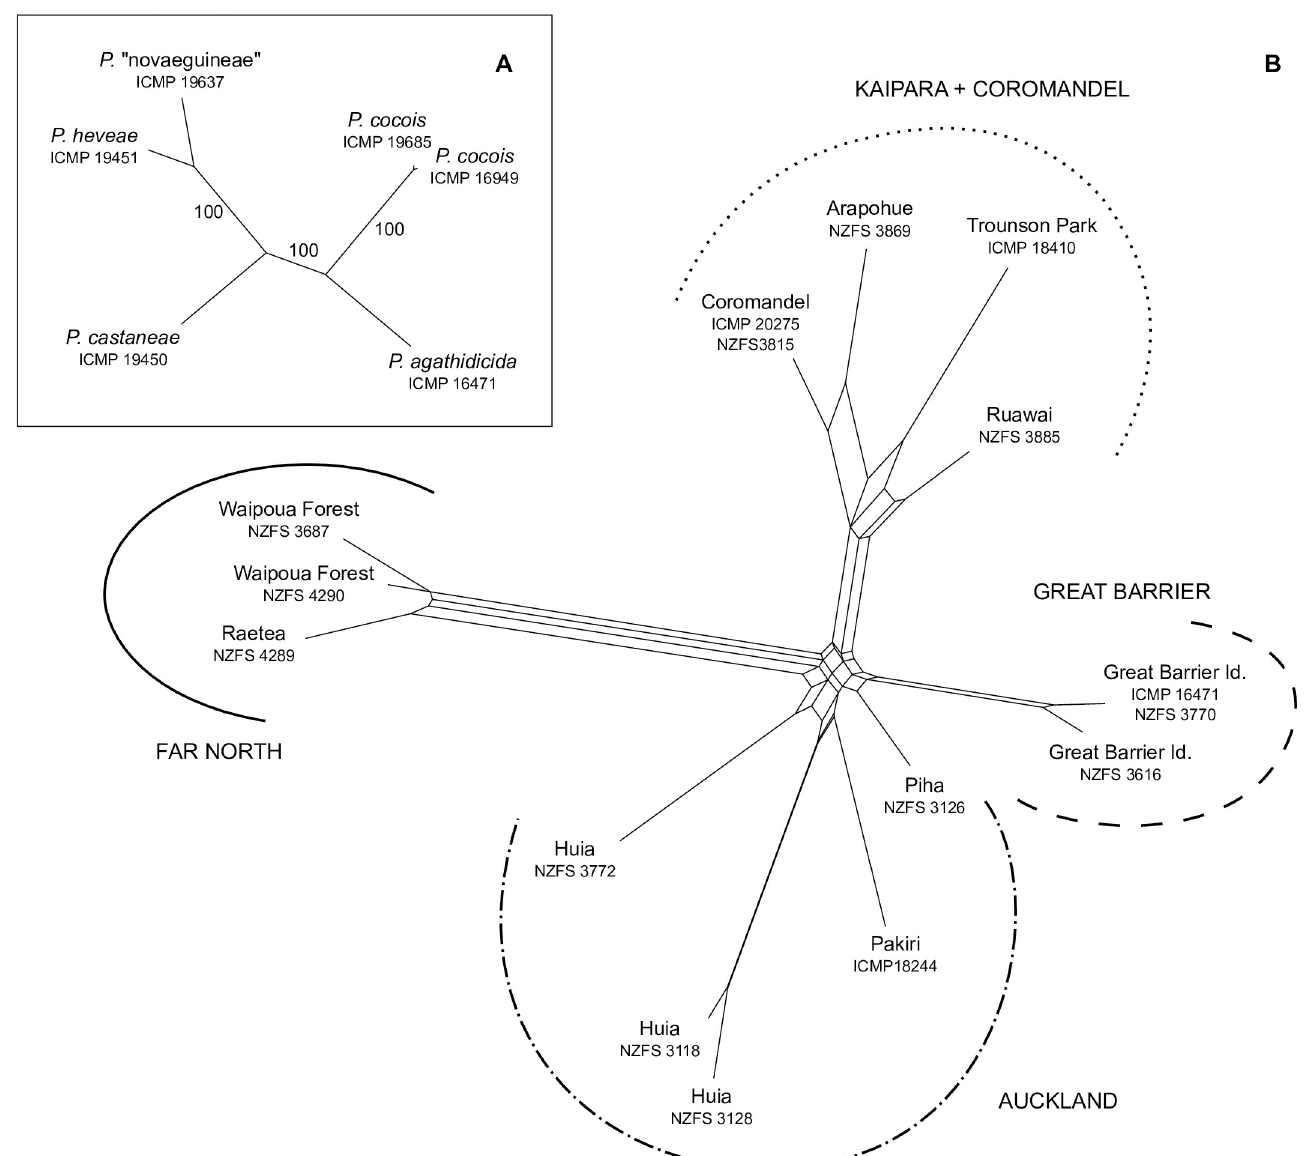
Fig 3. Phylogenetic reconstructions for Phytophthora agathidicida and related Phytophthora clade 5 taxa. A. Maximum likelihood tree describing relationships among members of Phytophthora clade 5. Tree obtained from analysis of complete mitochondrial genome sequences (likelihood = -54392.814), branches labelled with bootstrap values. B. Phylogenetic network describing relationships among the Phytophthora agathidicida accessions. Network obtained from Neighbor-Net analysis of complete mitochondrial genome sequences (Fit = 98.023). Terminals are labelled with collection location and accession number; four broad genetic groups are also